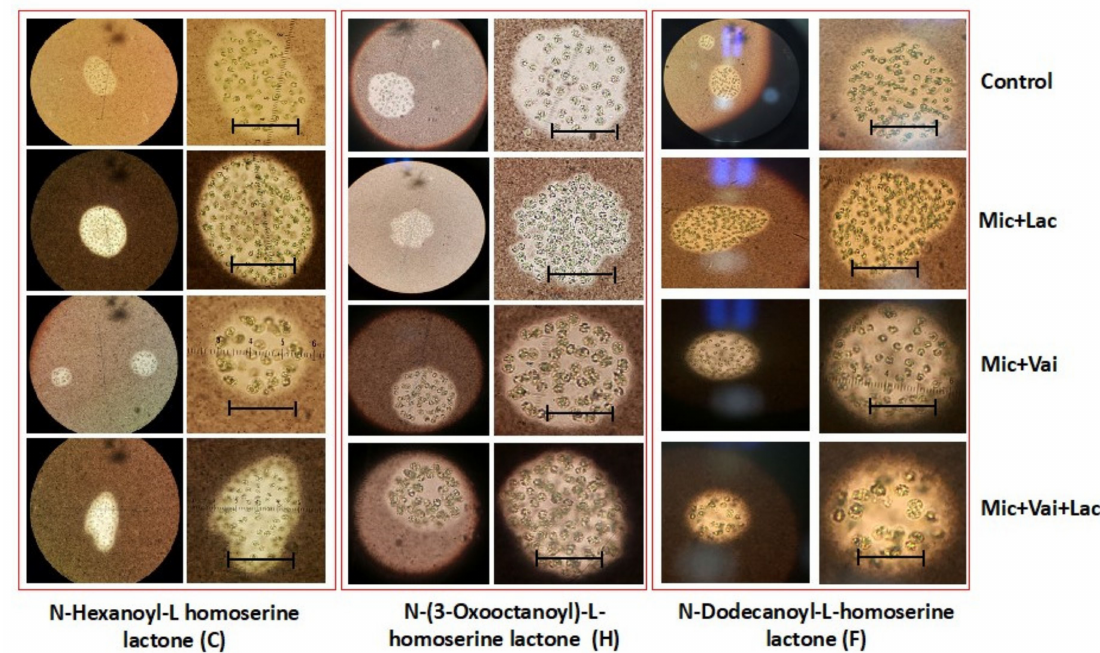
Figure 6. The appearance of M. aeruginosa colonies exposed to substances N- hexanoyl ( C ), N-dodecanoyl ( F ), and N-3- oxooctanoyl-L homoserine lactone ( H ). 10X and 40X. Scale bar: 25 µ m. Mic + Lac: M. aeruginosa with lactone; Mic + Vai: M. aeruginosa treated with vanillin. Mic + Lac: Mic + Vai + Lac M. aeruginosa treated with lactone and then